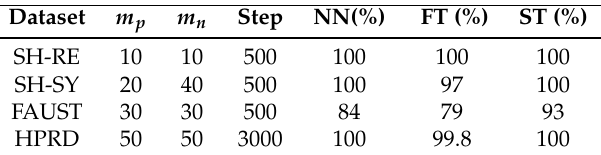
Table 4. Pose retrieval results of different datasets.